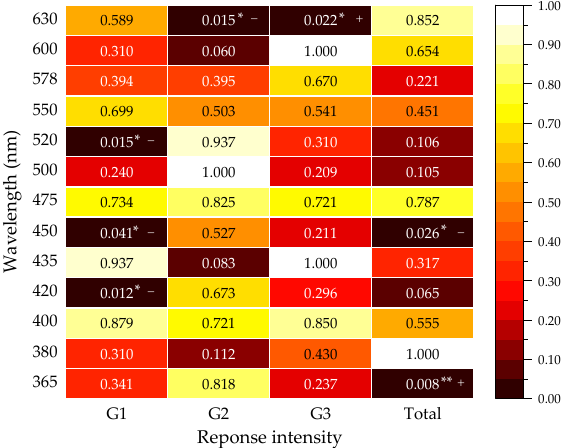
Figure 4. Comparative p ‐ value heatmap of phototactic responses of females and males at different wavelengths. * significant at p < 0.05 level, ** significant at p < 0.01 level by t ‐ test or Mann–Whitney U test. + The phototactic response rate of females was higher than that of males, − on the contrary.